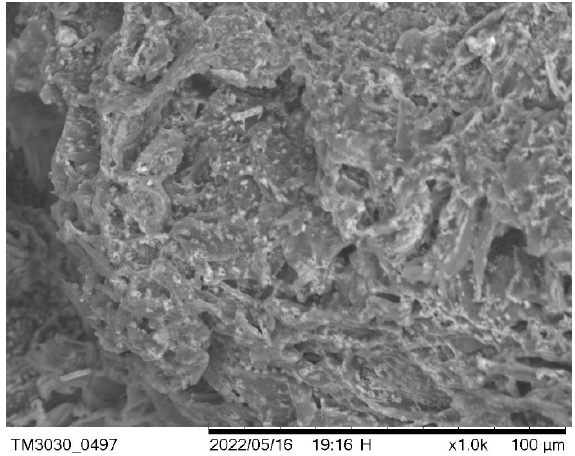
Figure 5. SEM image ( × 1000) of the biochar product for PP-BC-900-20. Since the oxygen complexes of biochar play a vital role in its polar nature (e.g., hy- drophilicity) [47], the oxygen-containing functional groups on the surface of the biochar products were analyzed by Fourier transform infrared spectroscopy (FTIR). Due to the similar FTIR patterns of all biochar products, Figure 6 only illustrates the FTIR spectrum of the optimal biochar product (i.e., PP-BC-900-20) in the range of 400–4000 cm − 1 , which is discussed below [21,22]: (1) The absorption peak at 3450 cm − 1 in the region of 3300–3700 cm − 1 should be assigned to the stretching vibration of the hydroxyl (O-H) group. (2) The peak at approximately 1647 cm − 1 could be associated with carbonyl (C=O) group stretching. (3) The sharp peak at 1380 cm − 1 could be due to C-O asymmetric stretching. (4) The peak at 1110 cm − 1 could be attributed to C-O-C aliphatic/ether stretching. (5) Several weak peaks in the region of <1000 cm − 1 were assigned to be due to C-H bending for aromatic out-of-plane deformations. Figure 6. FTIR spectrum of the biochar product (PP-BC-900-20). On the other hand, the elemental compositions of the biochar products and PP were detected by EDS, which showed that the main elements on the surface of the biochar products included carbon (>60 wt %) and oxygen (30–35 wt %), though differing